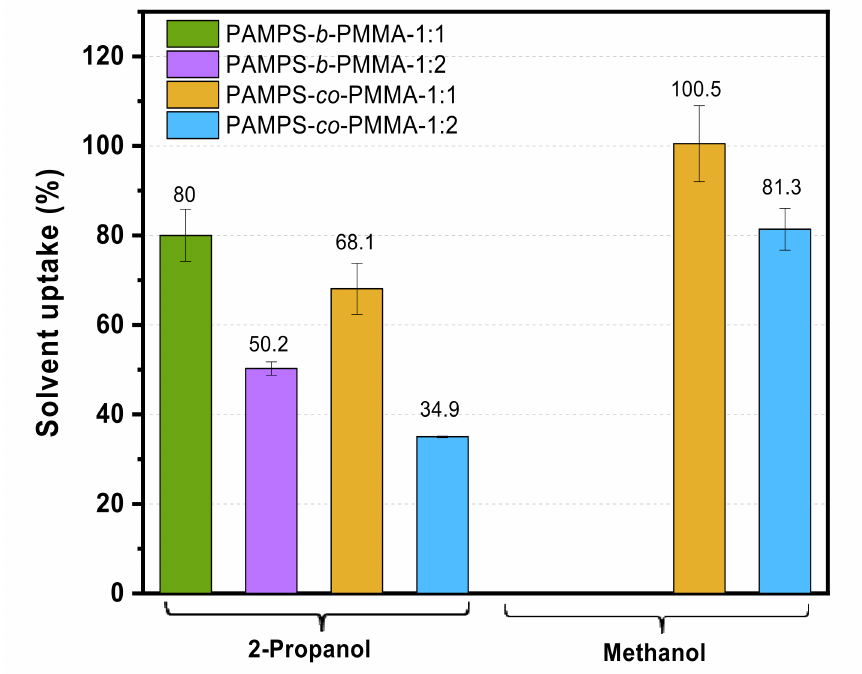
Figure 4. The 2-propanol and methanol uptake of membranes made from PAMPS -b -PMMA and PAMPS- co -PMMA copolymers at different PAMPS